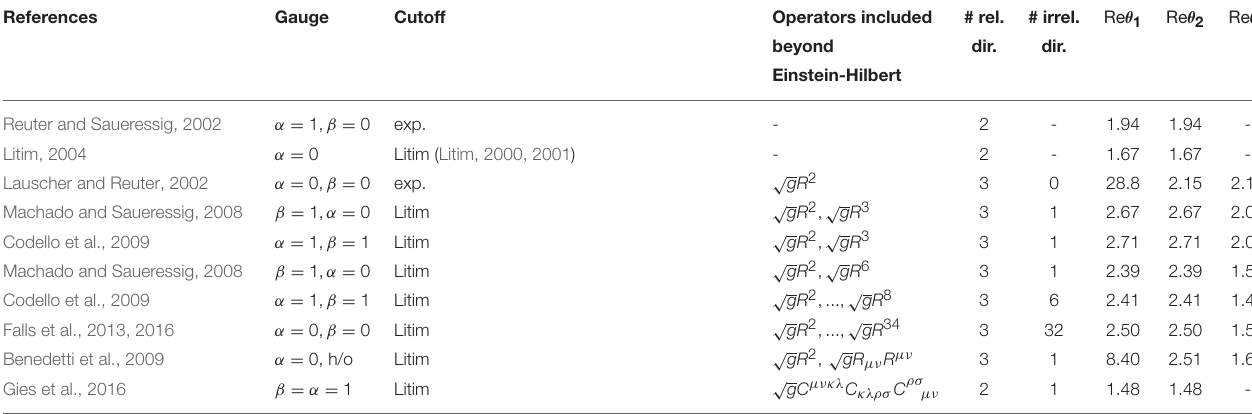
TABLE 2 | The operators beyond Einstein-Hilbert, the number of relevant/irrelevant directions, and the values of the positive critical exponents are indicated. Gauge Cutoff